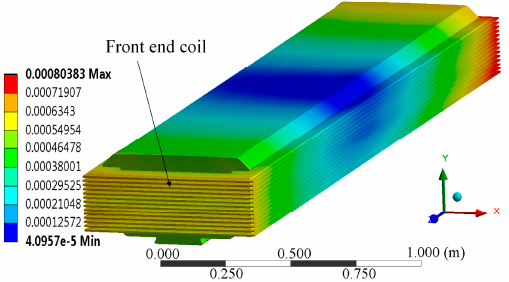
Figure 10. Thermal deformation of rotor magnetic pole under normal conditions.